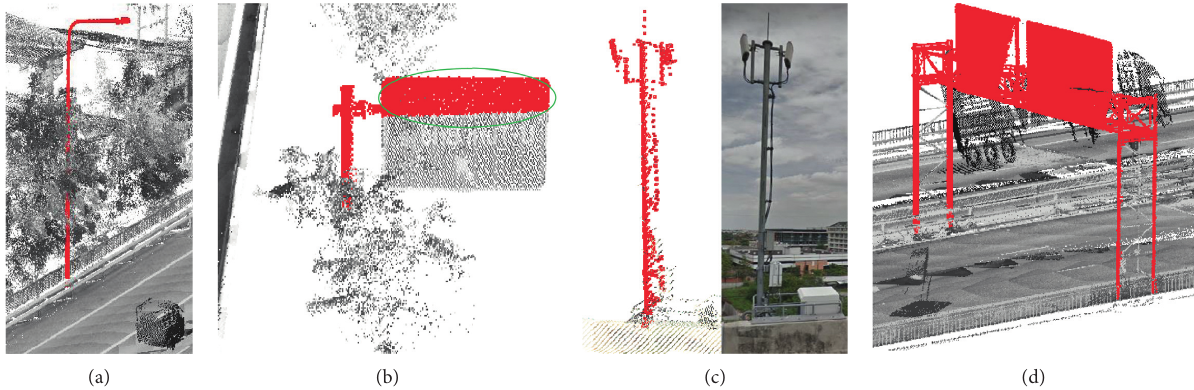
Figure 16: Performance of PLO detection. (a) Lighting pole mixed with tree crowns. (b) Traffic sign occluded by shrubs. (c) Tele- communication tower with the electricity cable connected to its trunk. (d) Overhead sign. All extracted PLOs are in